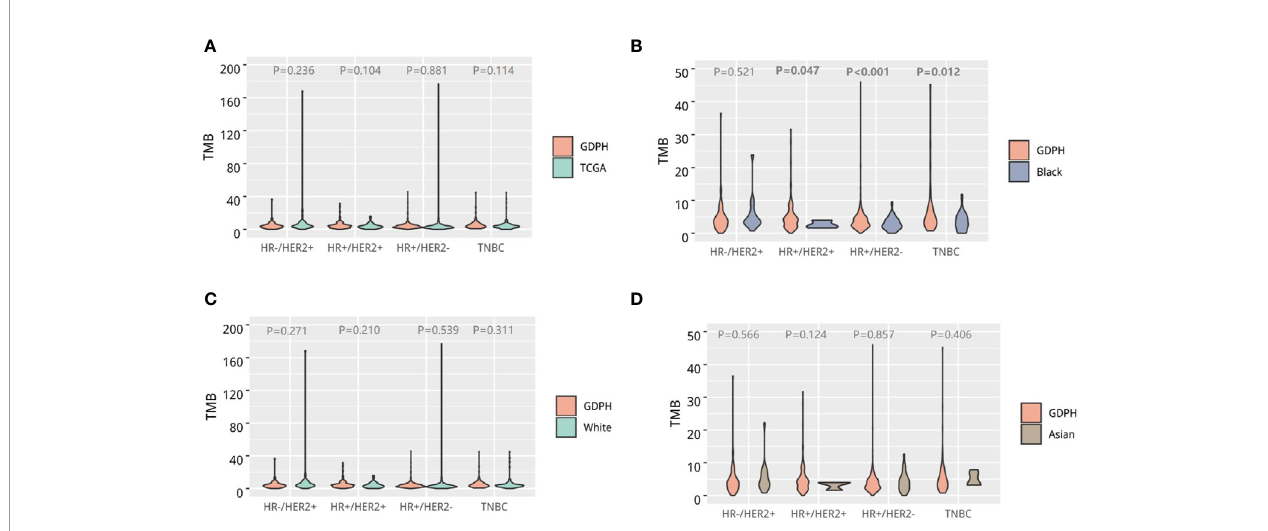
FIGURE 3 | Tumor mutational burden (TMB) of Chinese breast cancer. Violin diagram comparing the distribution of TMB across molecular subtypes between Chinese breast cancer and the whole TCGA breast cancer cohort (A) , African-American patients in the TCGA cohort (B) , Caucasian patients in the TCGA cohort (C) , and Asian patients in the TCGA cohort (D) . The outline of the violins shows the mirrored kernel density, with the red dot indicating the median. Statistical comparisons were performed using Mann – Whitney U